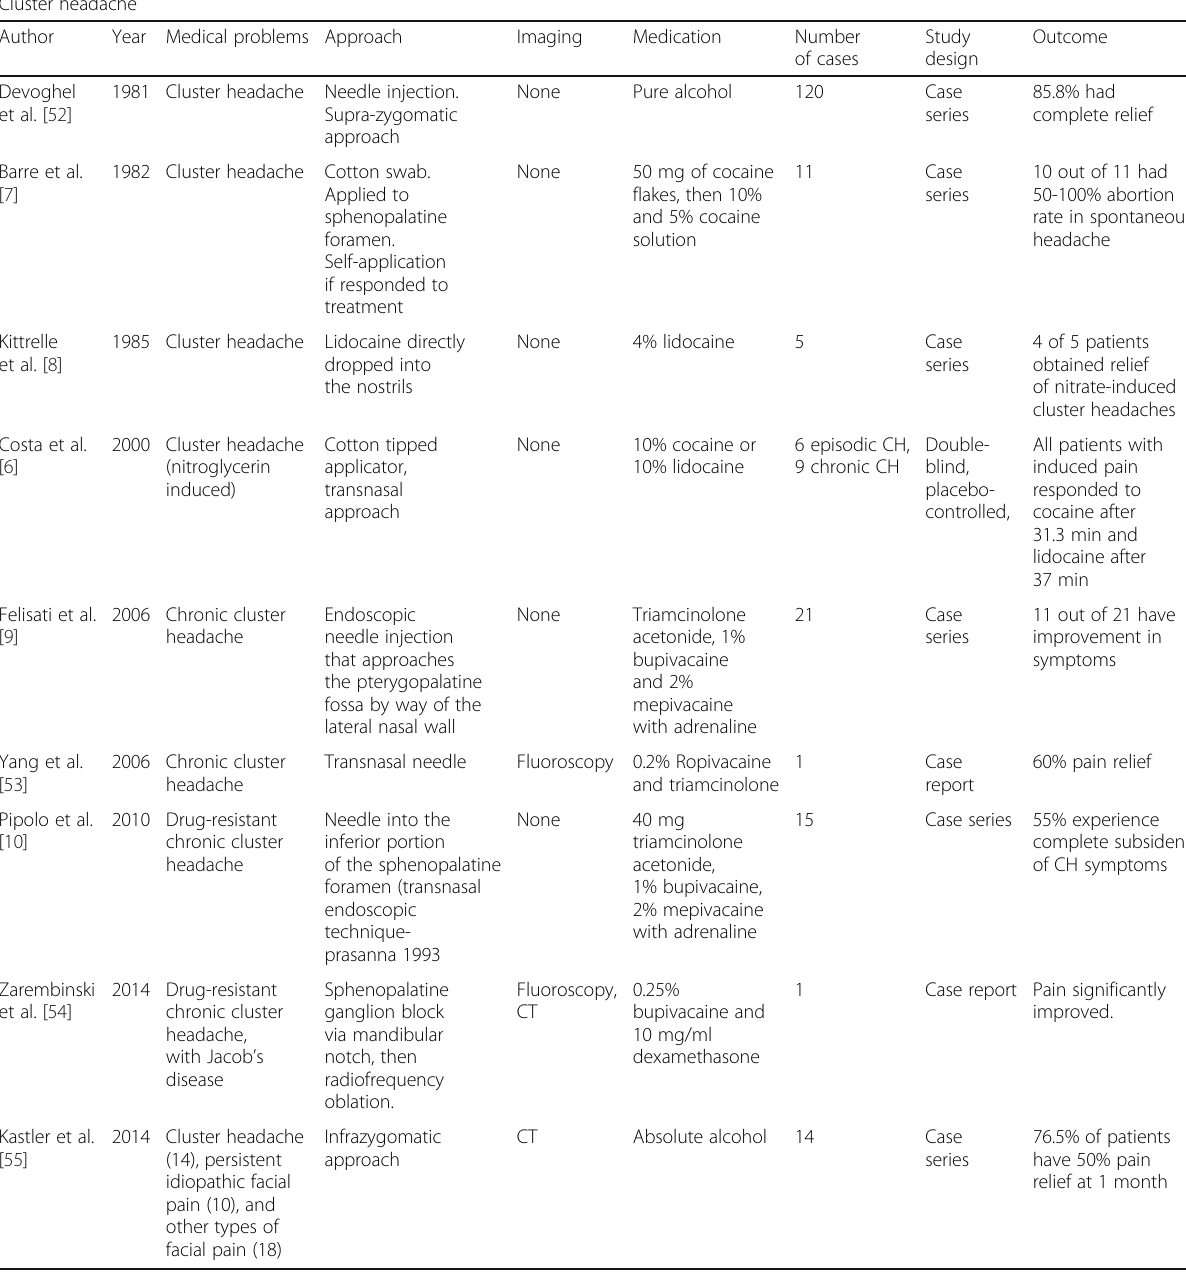
Table 3 Studies of SPG block for cluster headache Cluster